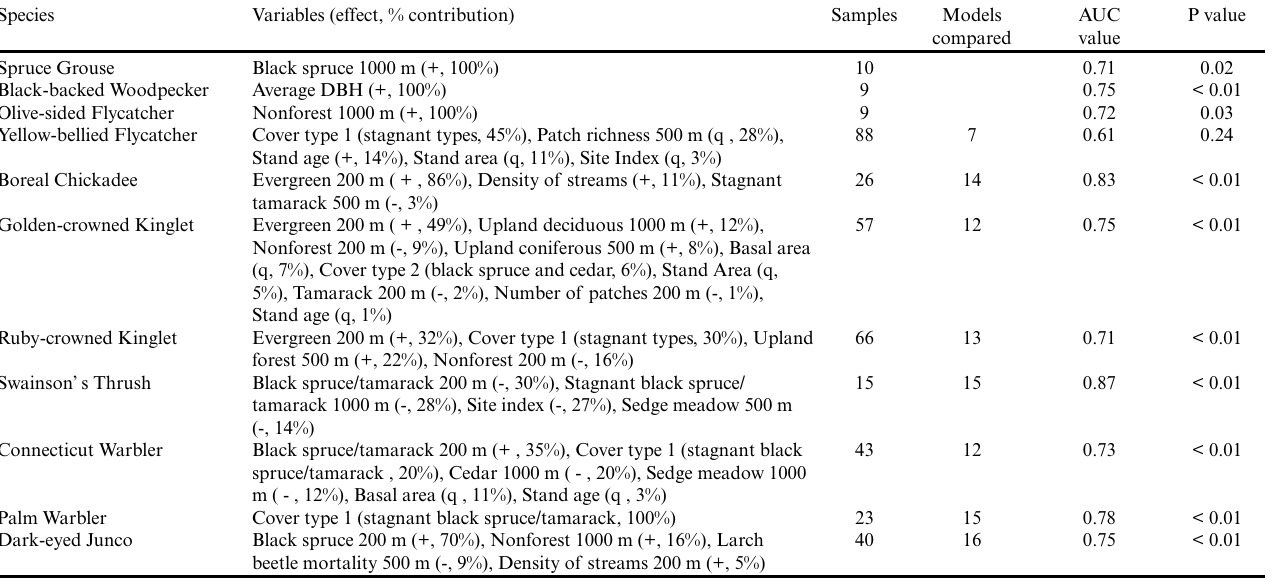
Table 4 . Best MaxEnt models for each of 11 species in the Agassiz Lowland Subsection as determined by lowest AICc value. Effects of environmental variables were positive (+), negative (-), categorical (top categories indicated), or quadratic (q). Area under the receiver operator curve (AUC) was used as a metric of model fit and was determined by averaging cross-validated model runs of test samples. Significance was determined by comparing AUC to the distribution of replicated (999) restricted-random MaxEnt models. Note, only single variable models were used for species with 10 or less observations (see methods). See Table 2 for species scientific names. Species Variables (effect, % contribution) Spruce